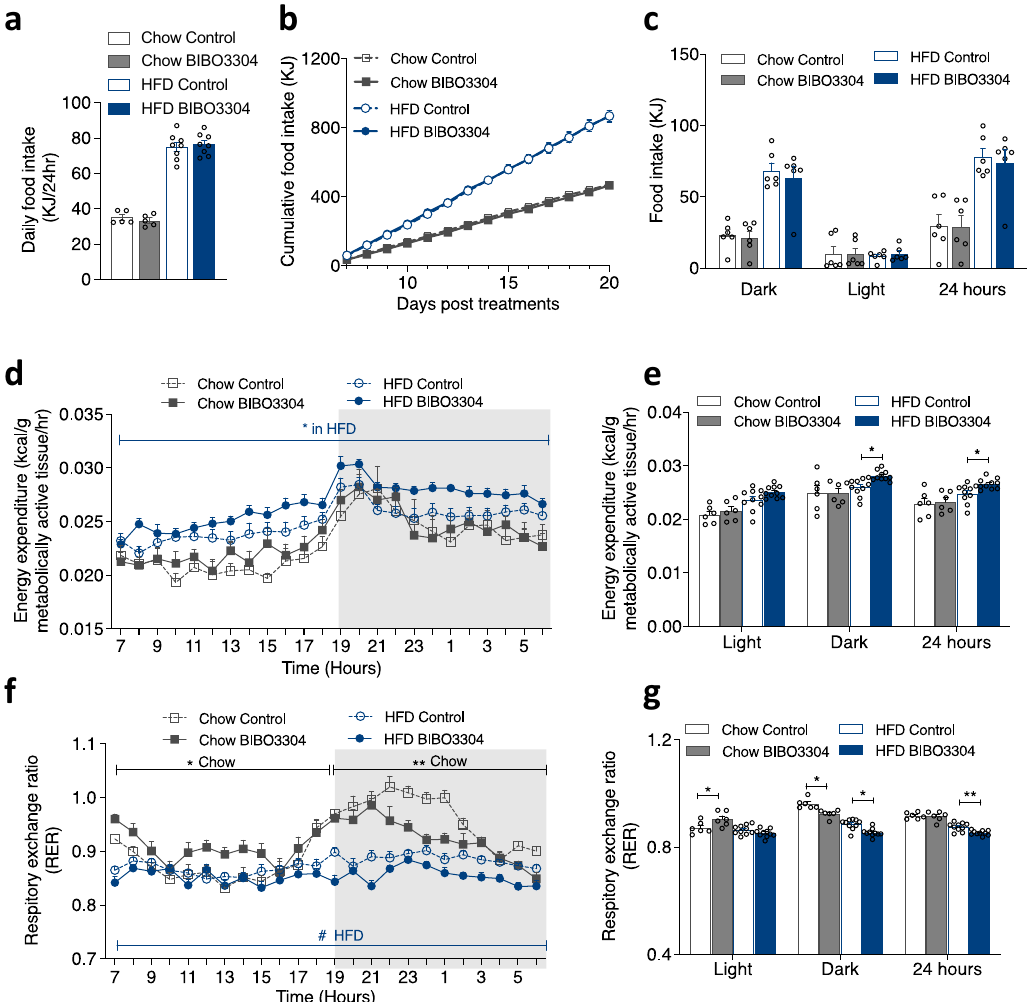
Fig. 2 Effect of peripheral Y1R antagonism on food intake and energy expenditure in wild-type mice. a Spontaneous daily food intake over fi rst 3 days of wild-type mice treated daily with a jelly containing either vehicle or BIBO3304 on a chow or a HFD at 8 weeks of age, Data are mean ± s.e.m, Chow n = 5 (control: open grey bar; BIBO3304: grey bar), HFD n = 8 (control: open blue bar; BIBO3304: blue bar). p values by one-way ANOVA. b Cumulative food intake of chow- and HFD-fed wild-type mice treated daily with a jelly containing either vehicle or BIBO3304 from day 6 to day 20 post treatment. Data are mean ± s.e.m, Chow n = 5 (grey, control: open square; BIBO3304: fi lled square), HFD n = 8 (blue, control: open circle; BIBO3304: fi lled circle). p values by two-way repeated measures ANOVA. c Food intake during the dark phase, light phase and over 24 h period of chow- and HFD-fed wild-type mice treated daily with a jelly containing either vehicle or BIBO3304 at 8 – 9 weeks of age. Data are mean ± s.e.m, n = 6 per group. p values by one-way ANOVA. d Energy expenditure (normalized to metabolically active tissues) over a 24-h course, with e showing average energy expenditure during the light phase, dark phase and over a 24-h period from ( d ). f Respiratory exchange ratio (RER) over a 24-h period, with ( g ) showing RER during the light phase, dark phase and over a 24-h period from ( f ). Data ( d , e , f , g ) are mean ± s.e.m. Chow n = 6, HFD n = 10, * p < 0.05, ** p < 0.01 vs control in the same diet, one-way ANOVA with Tukey ’ s multiple comparisons test. Source data are provided as a Source Data fi